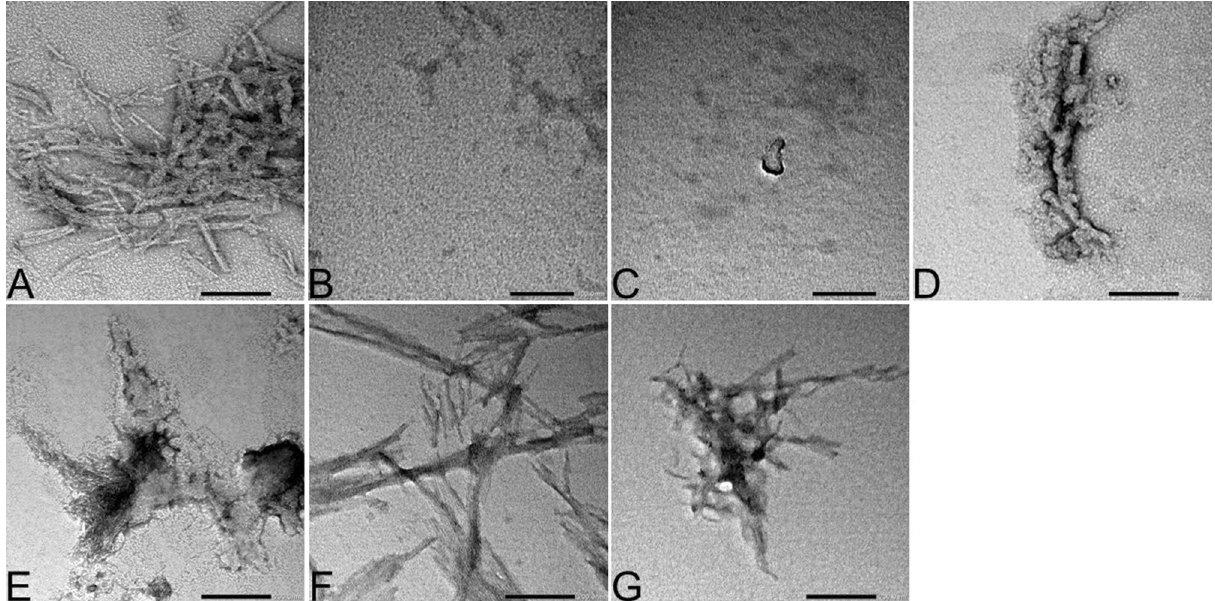
Figure 5. Transmission electron microscopic (TEM) images of human and equine α-synuclein (α-syn) peptide fragments at the end of kinetics of fibril formation (after 96 h of incubation at 37 °C). ( A ) TEM images of human α-syn full-length recombinant peptide at the end of the kinetics of aggregation. (Scale bar, 200 nm.) ( B ) TEM image of human and equine α-syn synthetic fragment 1–25. (Scale bar, 100 nm.) ( C ) TEM image of human and equine α-syn synthetic fragment 26–50. (Scale bar, 100 nm.) ( D ) TEM image of human α-syn synthetic fragment 37–61. (Scale bar, 200 nm.) ( E ) TEM image of equine α-syn synthetic fragment 37–61.